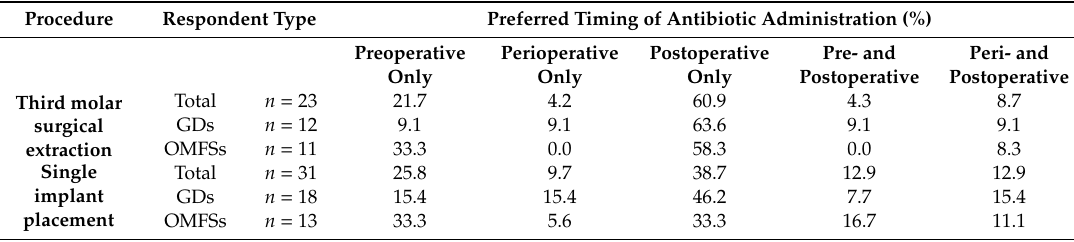
Table 3. Preferred timing of antibiotic administration of practitioners who prescribed